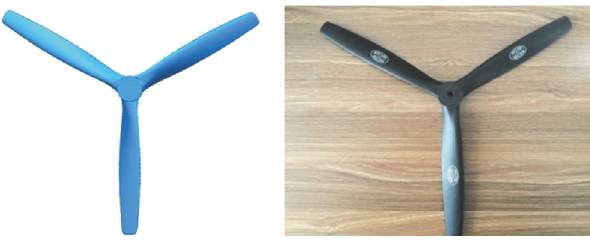
Figure 2: Computational model of rotor.